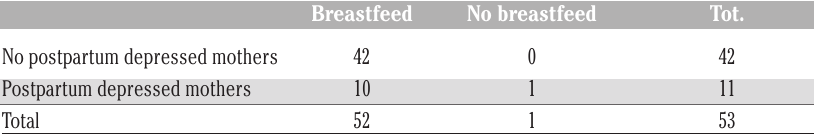
Table 5. Comparison between mothers who breastfeed their child and mothers who not breastfeed them. Breastfeed No breastfeed